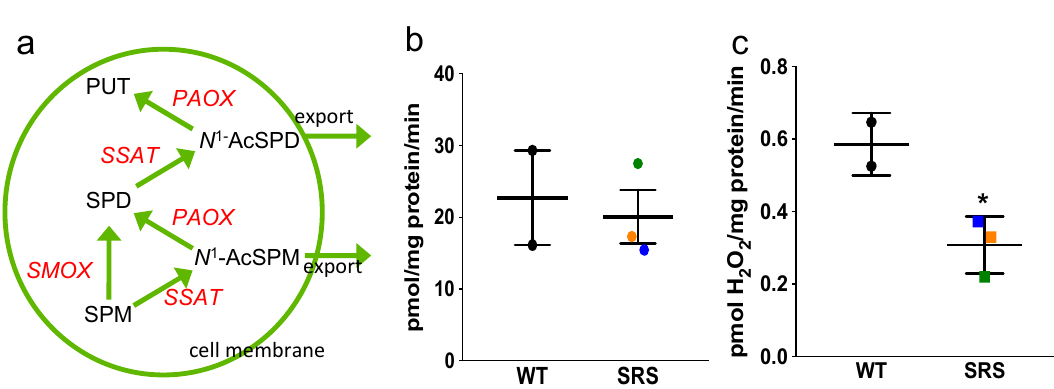
Figure 5. ( a ) The polyamine catabolic pathway. ( b ) Spermidine/spermine N 1 -acetyltransferase (SSAT) and ( c ) N 1 -acetylpolyamine oxidase (PAOX) activity assays. Color designations in (b,c) are orange for SRS1, blue for SRS2, and green for SRS3. Error bars indicate SEM ( n ≥ 2, in triplicate; * p < 0.05).